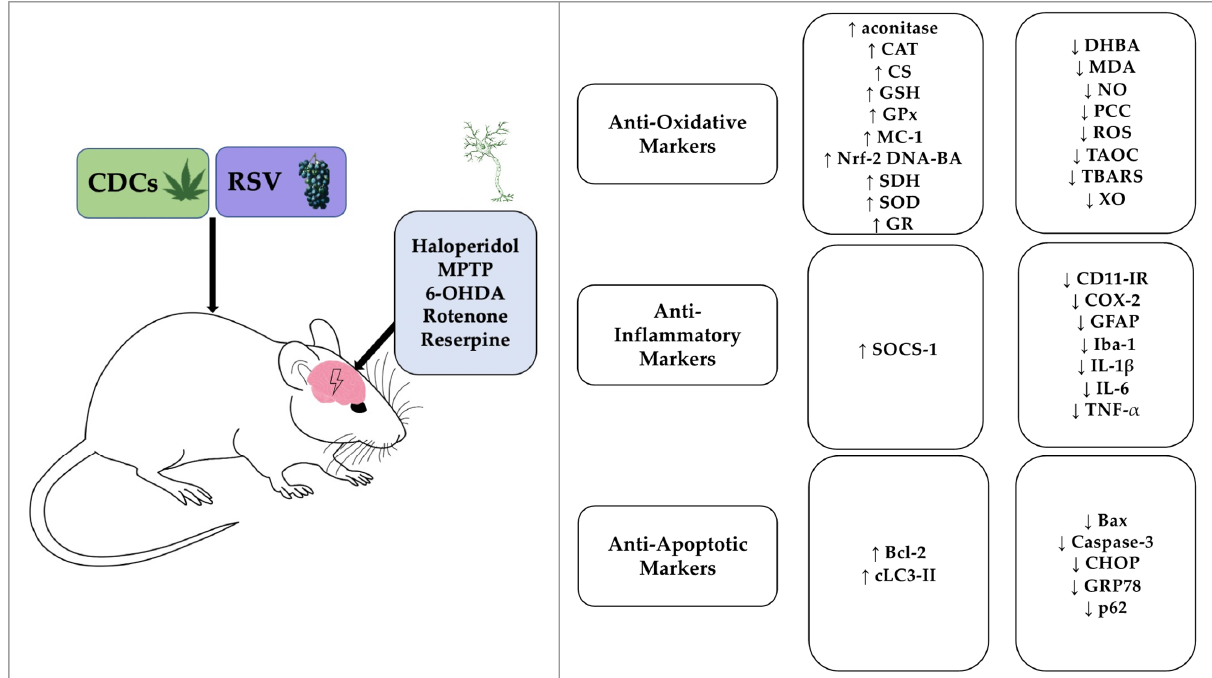
Figure 2. Schematic summary of the neuroprotective effects of CDCs or RSV following induction of PD in rodents. Abbre-